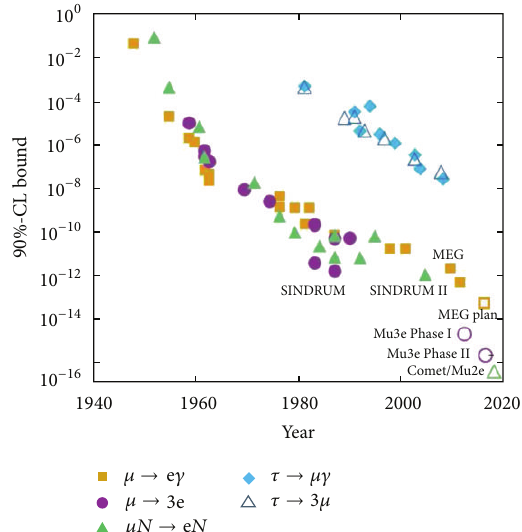
Figure 11: Experimental limits for branching fractions of CLFV processes involving muons and tau’s as a function of time. The open symbols represent the expected sensitivities of future projects: MEG upgrade, Mu3e, Mu2E and COMET (adapted from